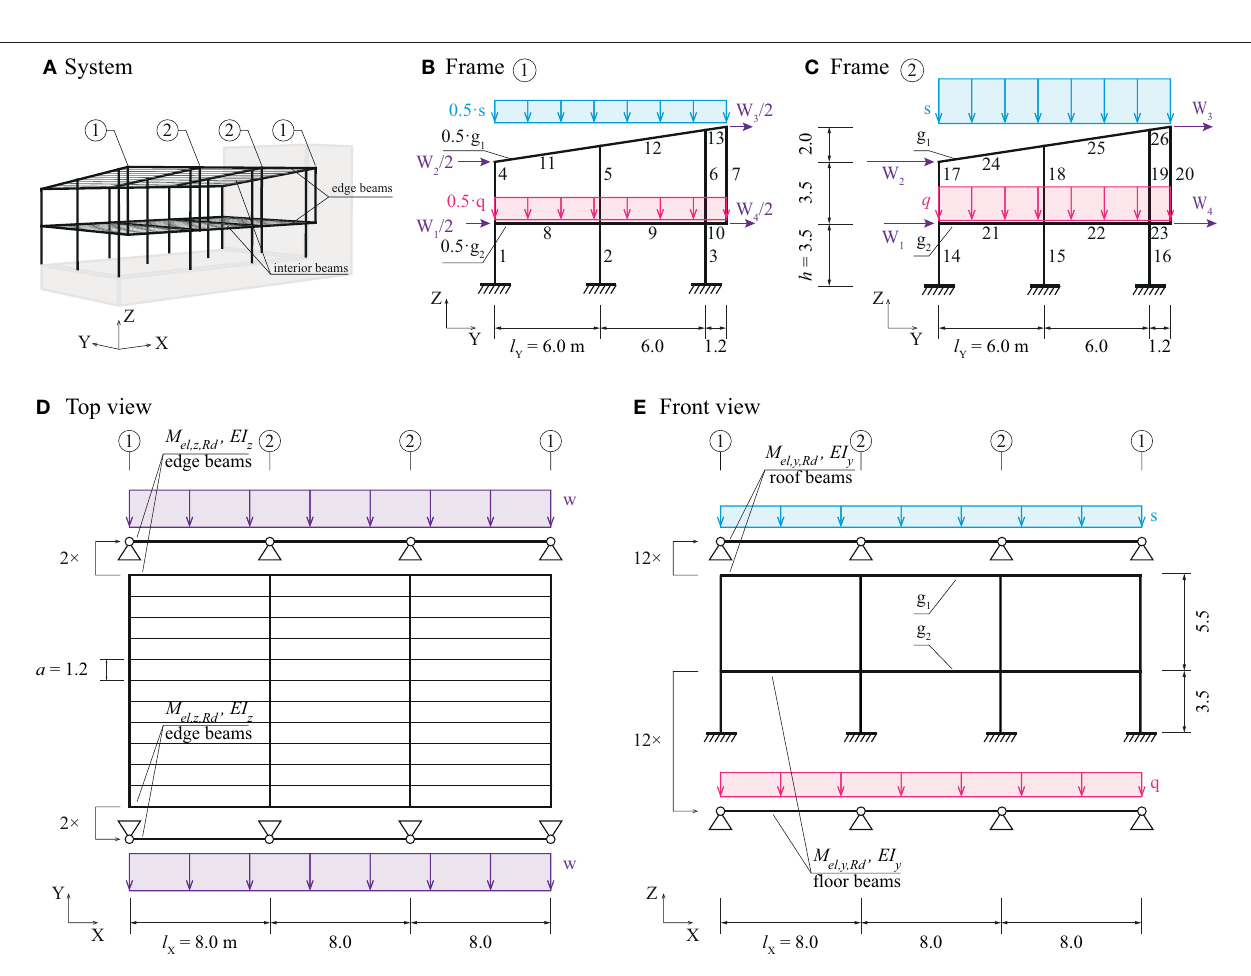
along the X-direction. Secondary beams of span l X